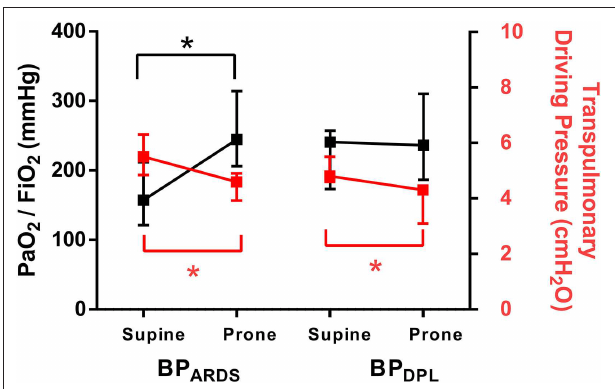
FIGURE 1 | Effect of prone positioning on PaO 2 /FiO 2 ratio (black, left y -axis) and on transpulmonary driving pressure (red, right y -axis) in both PEEP titration techniques. Symbols are median (25–75th percentile). * p < 0.05. PEEP: positive end-expiratory pressure; BP ARDS PEEP titrated according to the ARDS Network low PEEP/FiO 2 table; BP DPL PEEP set according to the lowest transpulmonary driving pressure.